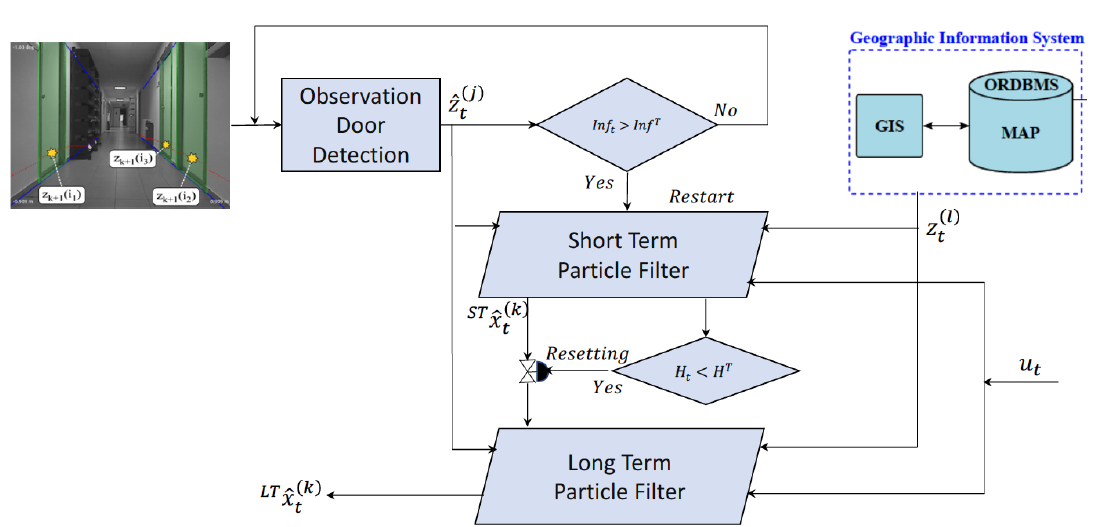
Figure 1. Core components of Environmental Stimuli Localization (ESL) method: the dual particle filter, Geographical Information System (GIS) map and landmark